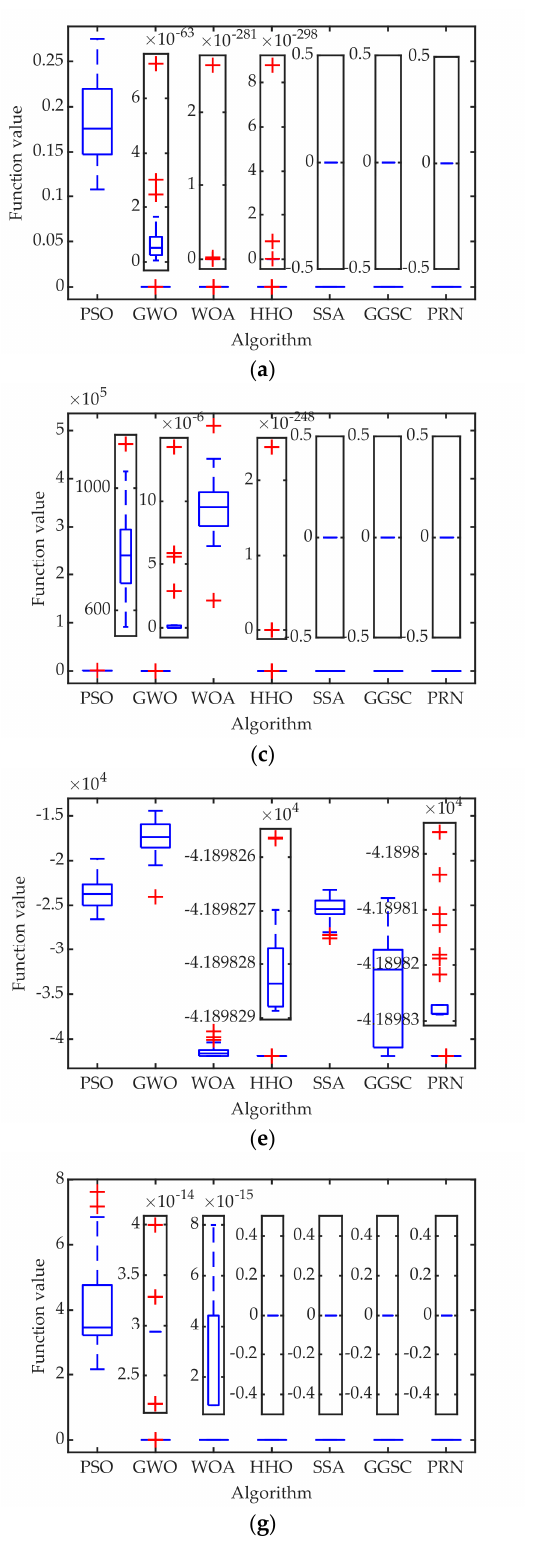
Figure 11. Boxplot for each algorithm optimization comparison (100-dimension): ( a ) f 1 ; ( b ) f 2 ; ( c ) f 3 ; ( d ) f 4 ; ( e ) f 8 ; ( f ) f 9 ; ( g ) f 10 ; ( h ) f 11